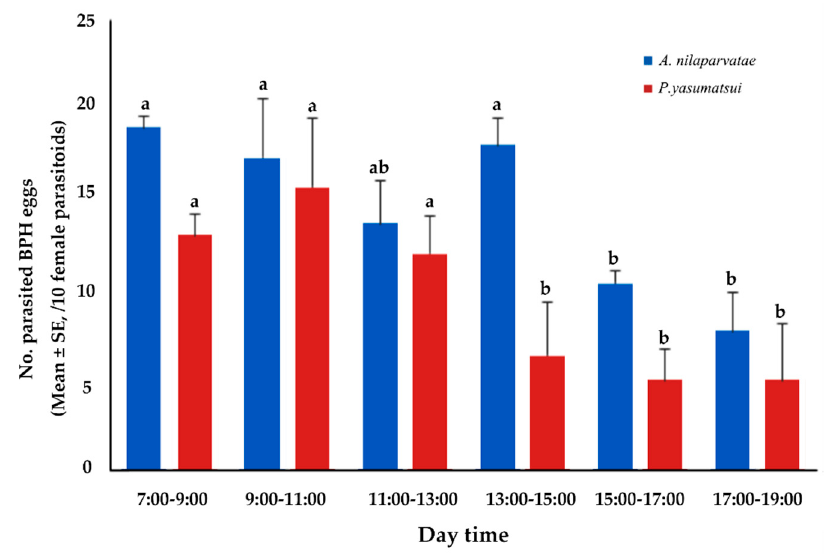
Figure 5. Distribution of parasitism events of the two egg parasitoids during daytime. Significant differences of the same egg parasitoid are marked with different letters (Tukey’ HSD, p < 0.05).